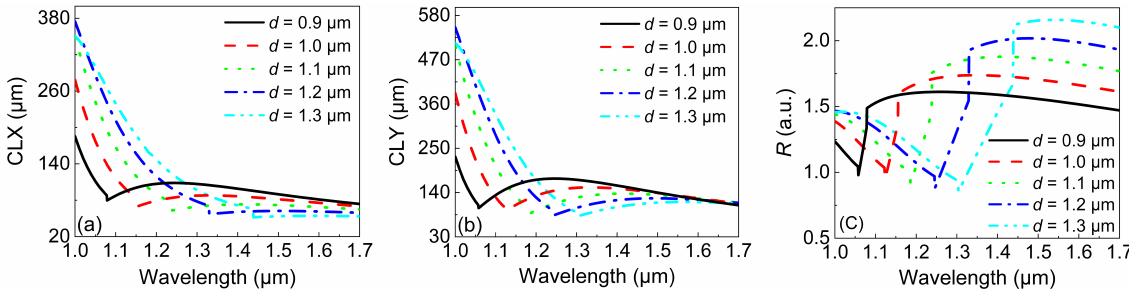
Figure 4. The variations in ( a ) the CLX and ( b ) CLY with the wavelength under different values of d . ( c ) The variations in R with the wavelength under different values of d .